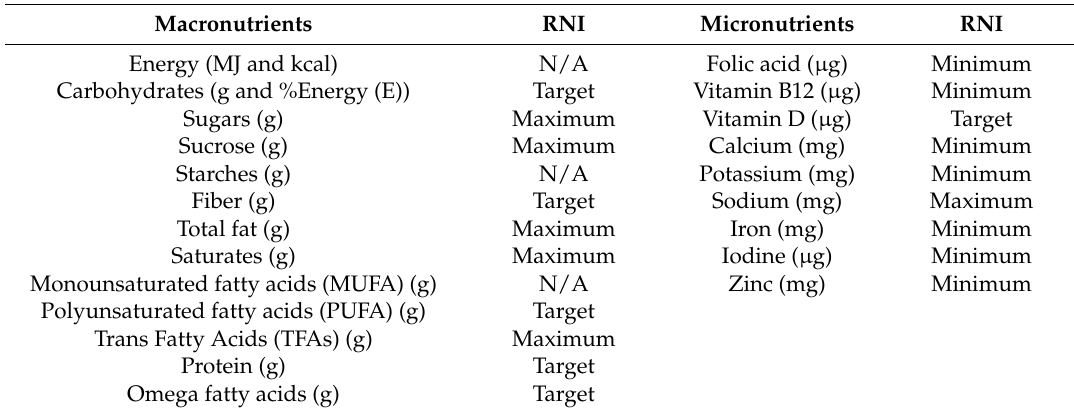
Table 2. Nutrients of interest in dietary